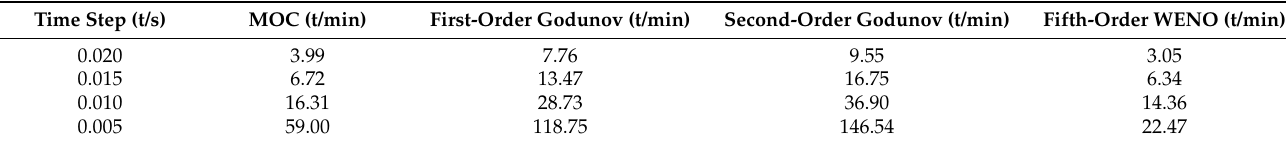
Table 3. The calculation time of different simulation methods.